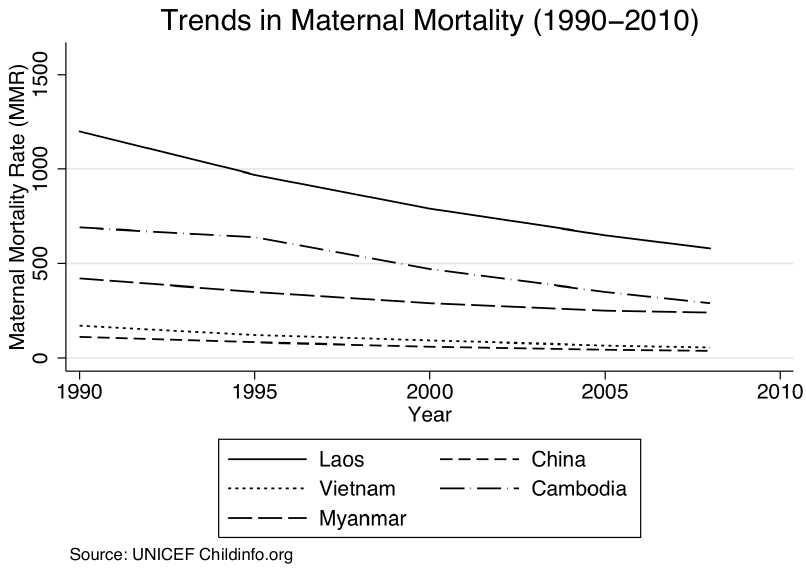
Figure 1. Trends in Maternal Mortality (1990–2010). (Source: UNICEF Childinfo.org).